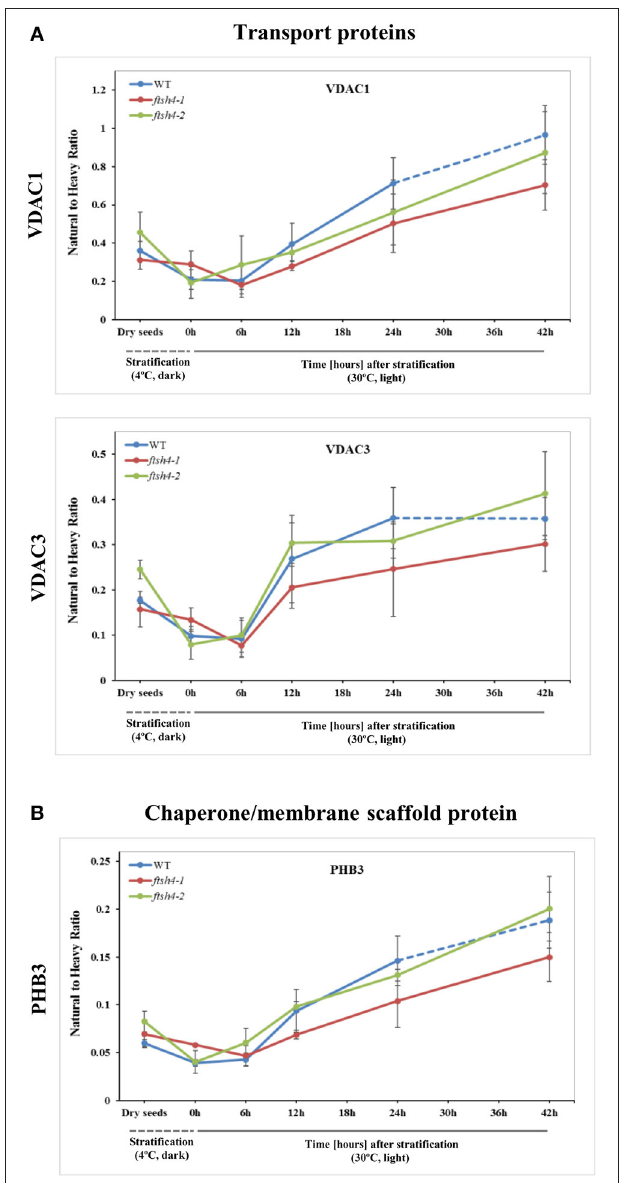
FIGURE 7 | Quantitative time-course profiling of mitochondrial transport proteins, VDAC1 and VDAC3 (A) , and chaperone/membrane scaffold-like protein PHB3 (B) in ftsh4 mutant seeds in comparison to those of WT during germination estimated by MRM. (A) Data show the abundance of VDAC1 (At3g01280) determined as the geometric mean of the peptides SFFTISGEVDTK, DSTITVGTQHSLDPLTSVK and FSITTFSPAGVAITSTGTK as well as the abundance of VDAC3 (At5g15090) and the peptides GSLFLGDVATQVK, SFFTVSGEVDSK and HFNAGFNFTK. (B) Data show the abundance of PHB3 (At5g40770) determined as the geometric mean of the peptides EIASTLAR, VLSRPEVSR and AVIFDR. Other descriptions are the same as in Figure 4 . Data are mean ± SD of three independent biological